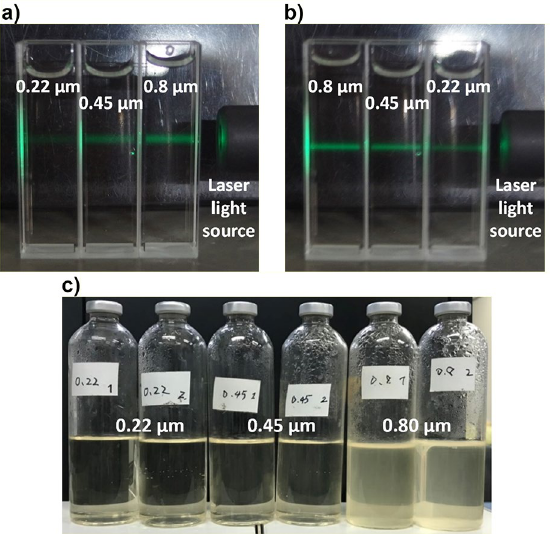
Figure 1. Photo images of scattered light observed by irradiating green laser in the carbon dioxide nanobubbles medium which had been filtered with membrane filters and the culture media which were filtered with membrane filters and anaerobically cultured at 30 °C for 10 days. ( a,b ) The carbon dioxide nanobubbles medium was filtered with membrane filters whose pore size was 0.22 μm, 0.45 μm and 0.80 μm respectively. The green laser light irradiated the carbon dioxide nanobubbles medium from right to left, while the alignment of the samples was opposite each other in ( a,b ). It was clearly observed that the intensity of scattered light became lower as the pore size of filter which had been used for the filtration of the carbon dioxide nanobubbles medium became smaller, suggesting that more nanobubbles had been caught with the filter whose pore size was smaller. ( c ) Each two culture medium on the left, center and right had been filtered with 0.22 μm, 0.45 μm and 0.80 μm respectively. Every culture medium did not contain P . aeruginosa and the nanobubbles. The